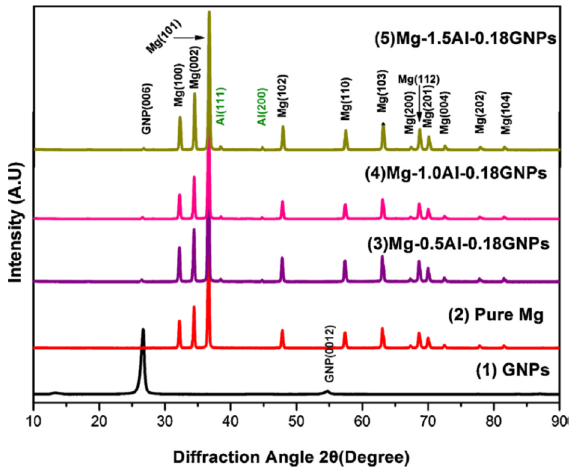
Figure 11. X ‐ ray diffraction patterns of GNP, pure Mg and Mg ‐ x Al ‐ 0.18 GNP composites ( x = 0.5; 1.0; 1.5), reproduced from [95], with permission from Elsevier, 2018. 1.5), reproduced from [95], with permission from Elsevier,